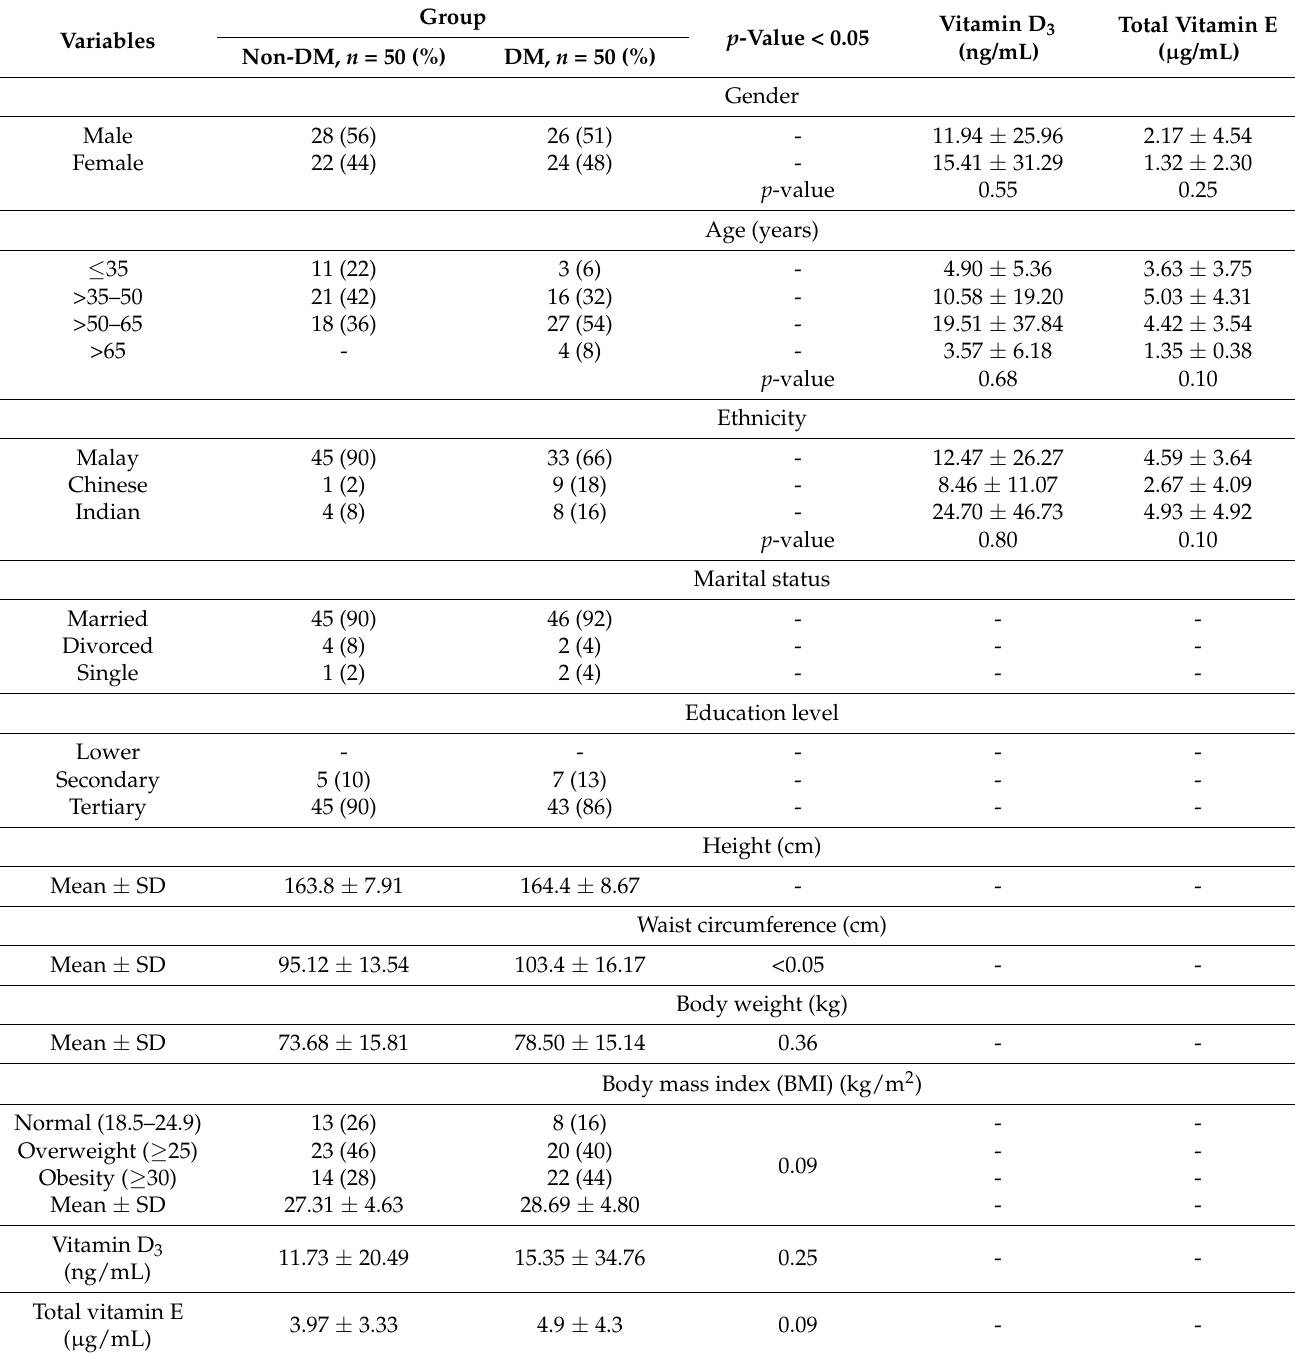
Table 1. Socio-demographic characteristics and anthropometric assessment of subjects in non-DM and DM groups.